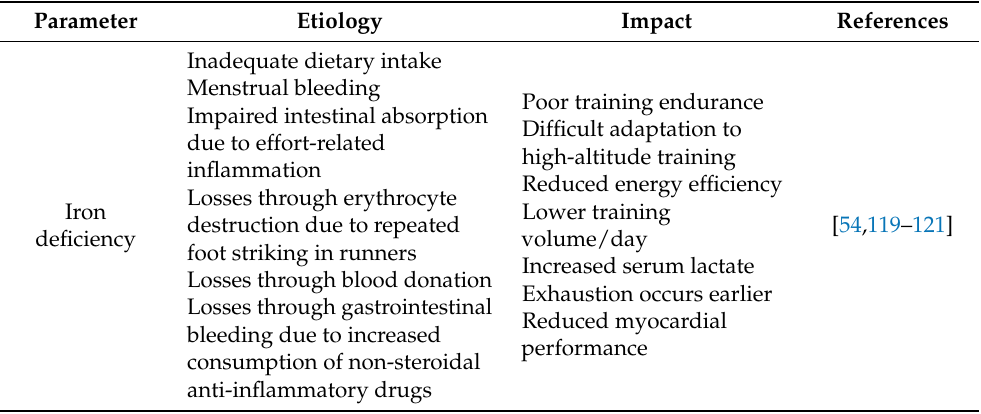
Table 2. Common causes of iron deficiency in athletes and their impact on physical performance and